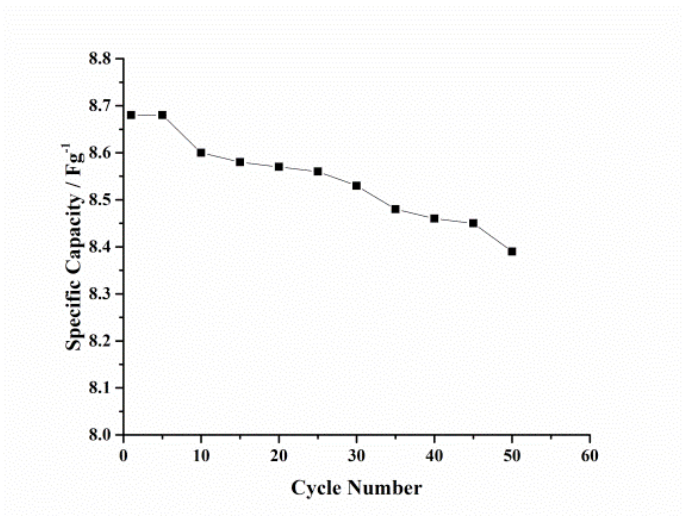
Figure 6: Variation of specific capacity with cycle